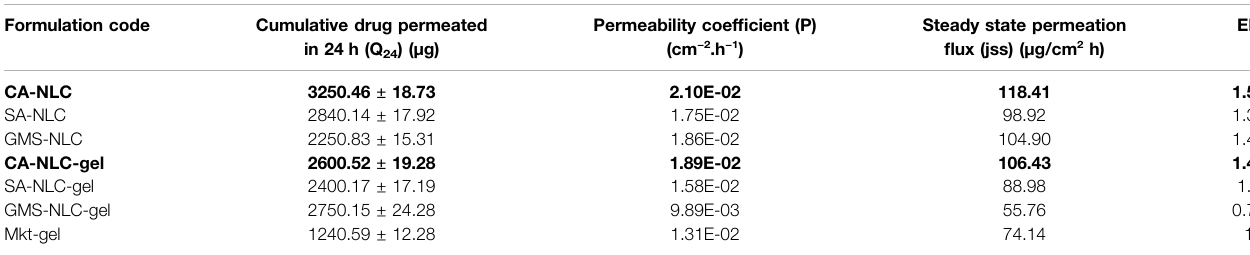
TABLE 3 | Characteristic skin transport parameters from various ACE formulations. Formulation